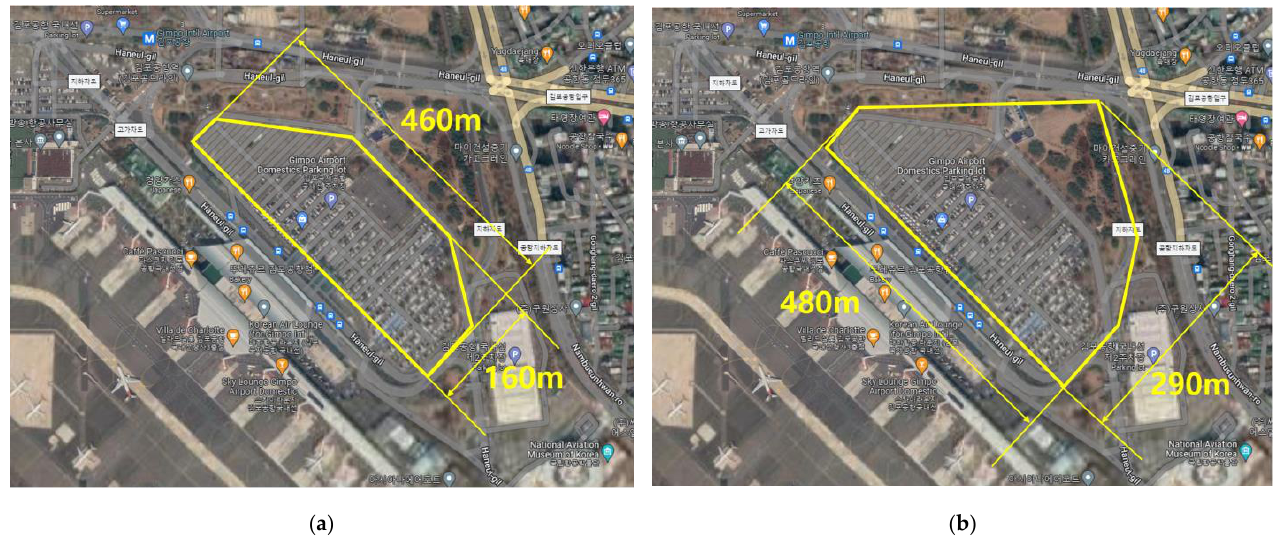
Figure 16. Two topologies for the Gimpo Airport parking lot: ( a ) current parking space; ( b ) expanded parking space.